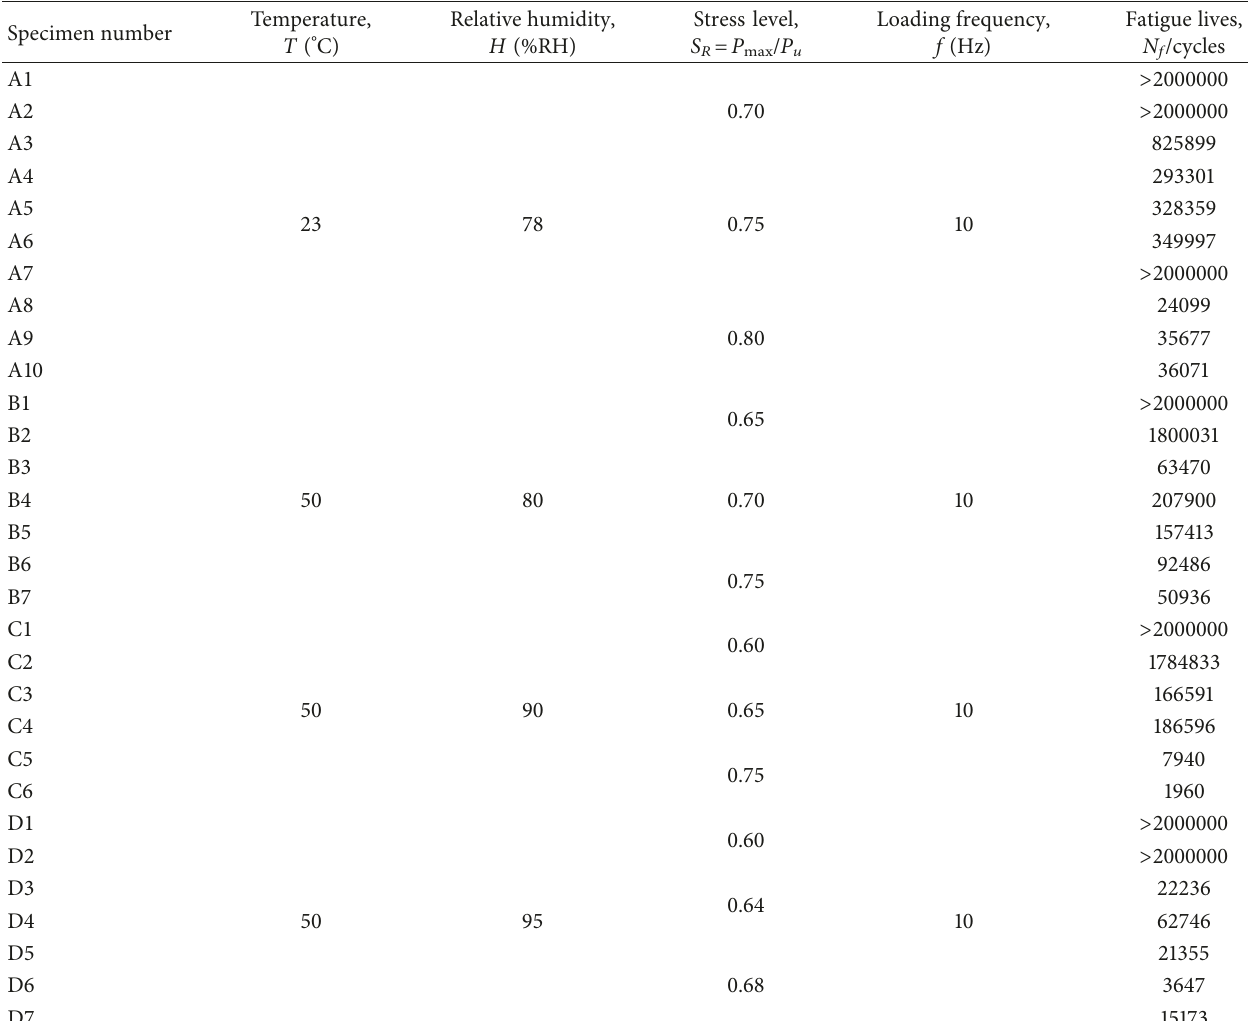
Table 2: Experimental conditions and results of group A ∼ D